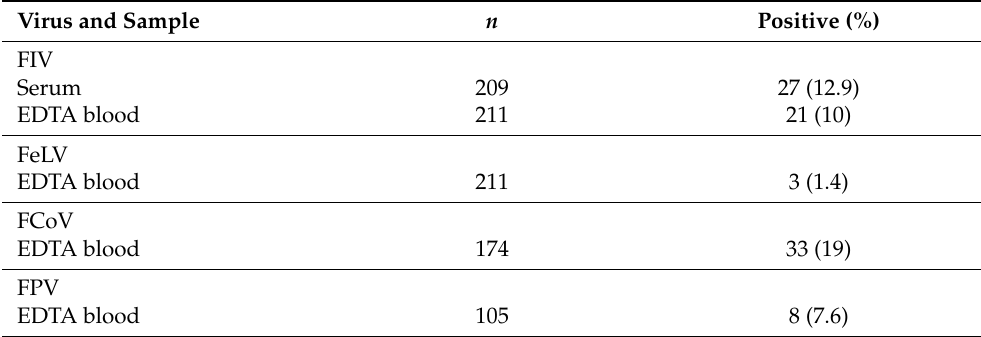
Table 7. Prevalence of the other investigated viruses with description of number ( n ) of serum and EDTA blood samples tested for antibody detection and PCR respectively for each virus.